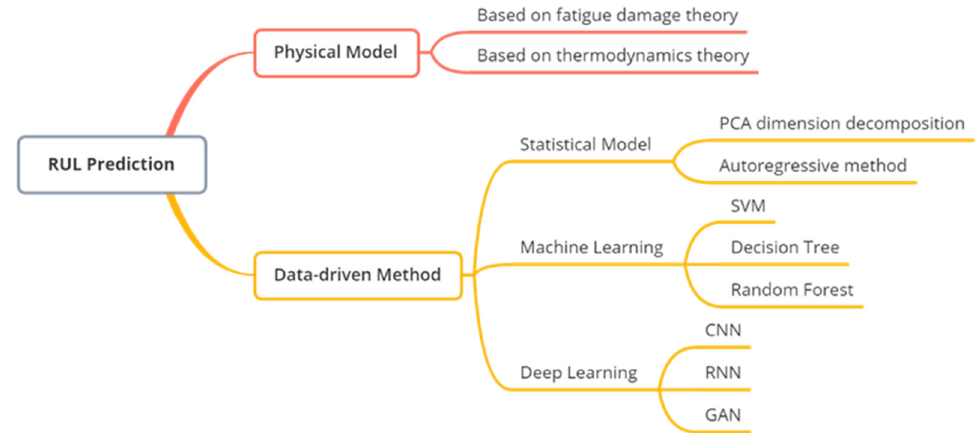
Figure 2. Classification of Remaining Useful Life (RUL) prediction method.